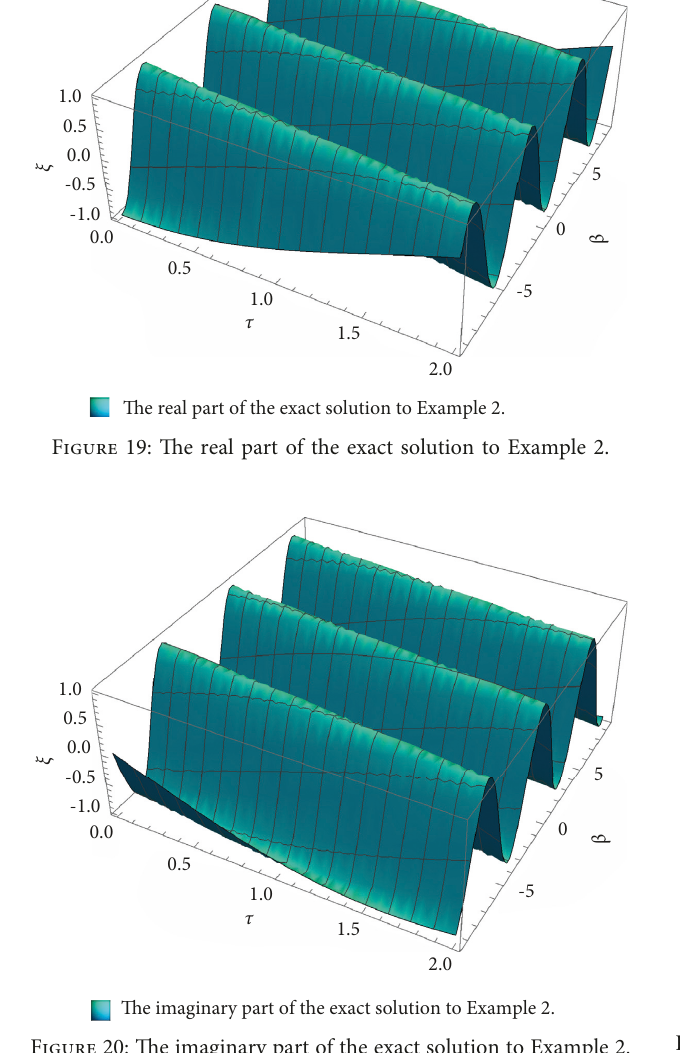
Figure 20: The imaginary part of the exact solution to Example 2.